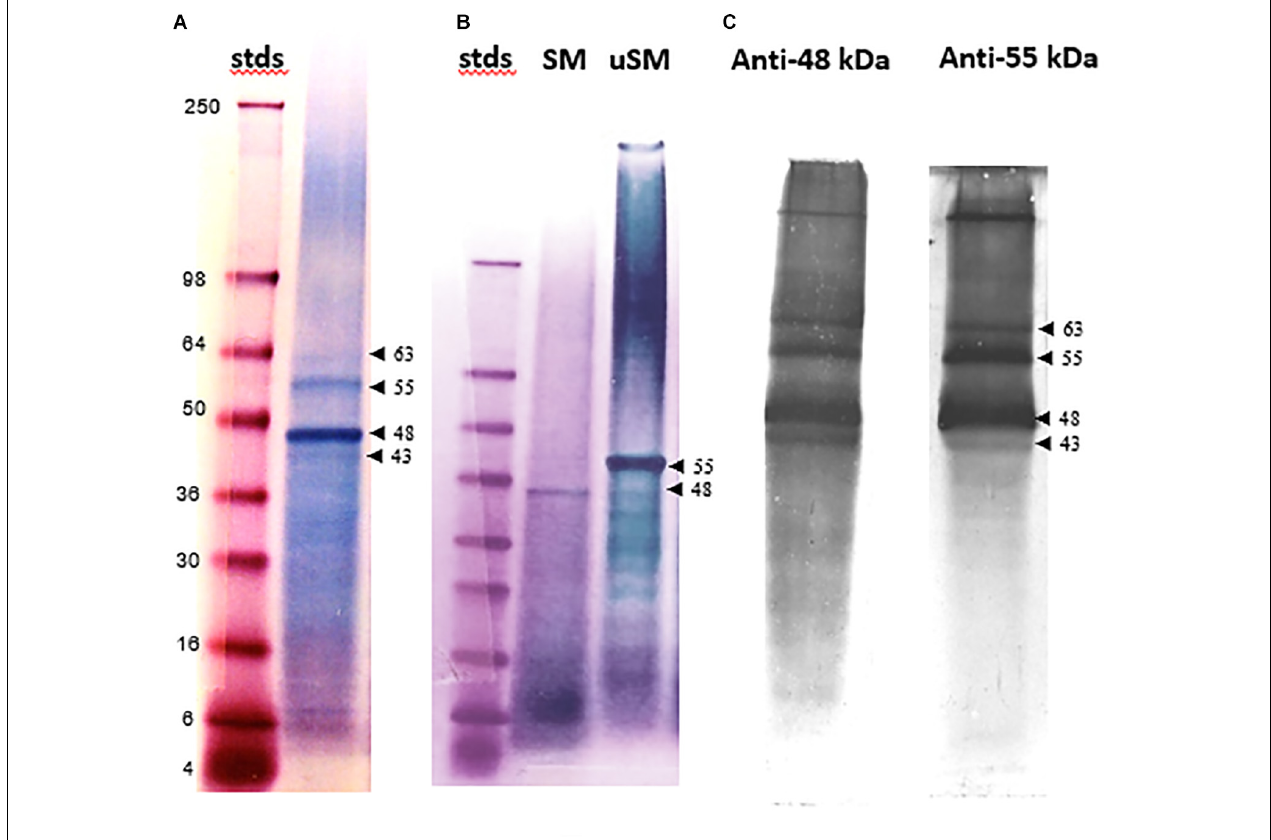
FIGURE 1 | SDS-PAGE and Western analyses of soluble shell matrix proteins. (A) Thirty-five µ g of EDTA soluble matrix (SM) was resolved on a 4–20% gradient Tris-glycine gel and stained with Stains-all. Standards (stds) were SeeBlue protein molecular weight markers labeled in kDa. Two prominent bands appear at 55 and 48 kDa while two adjacent minor bands occur at 63 and 43 kDa (arrow heads). (B) Thirty-five µ g SM and urea-solubilized matrix (uSM) were electrophoresed and stained as in (A). The position of the 55 and 48 kDa bands are indicated with arrow heads. While the 55 kDa band is not prominent in this preparation of SM, it is clearly the dominant band upon urea extraction of the insoluble matrix from this preparation. (C) Western analyses of SM extract immuno-stained separately with anti-48 kDa and anti-55 kDa antibodies. Both lanes contained 50 µ g of SM and were resolved on 12% Tris-glycine SDS gels. All four of the Stains-all positive bands identified in (A) are immuno-reactive with the anti-48 and anti-55 kDa antibodies (arrow heads). An additional high molecular protein that exceeded 98 kDa was also immune-reactive. All matrix loads are in quantities of protein as determined by BCA analysis. For these analyses, only lanes showing data pertinent to this study are